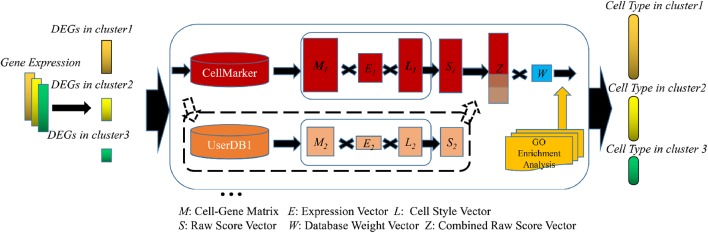
Flowchart of the SCSA. First, DEGs of each cluster will be extracted and filtered from gene expression file. Next, SCSA employs marker gene databases to annotate cell clusters. In this step, both known marker gene database and user-defined marker database could be used simultaneously. For each cluster each database, a cell-gene matrix (M) with two vectors (E, L) will be generated to form a raw score vector (S). If multiple databases were selected, vectors would be normalized and combined together to make a new vector (Z), then multiplied with a database weight matrix (W) to make the last uniform vector. In the last step, ranked cell type vector will be generated according to the uniform score. In addition, SCSA employs GO enrichment analysis to give users some clue for unidentified clusters.